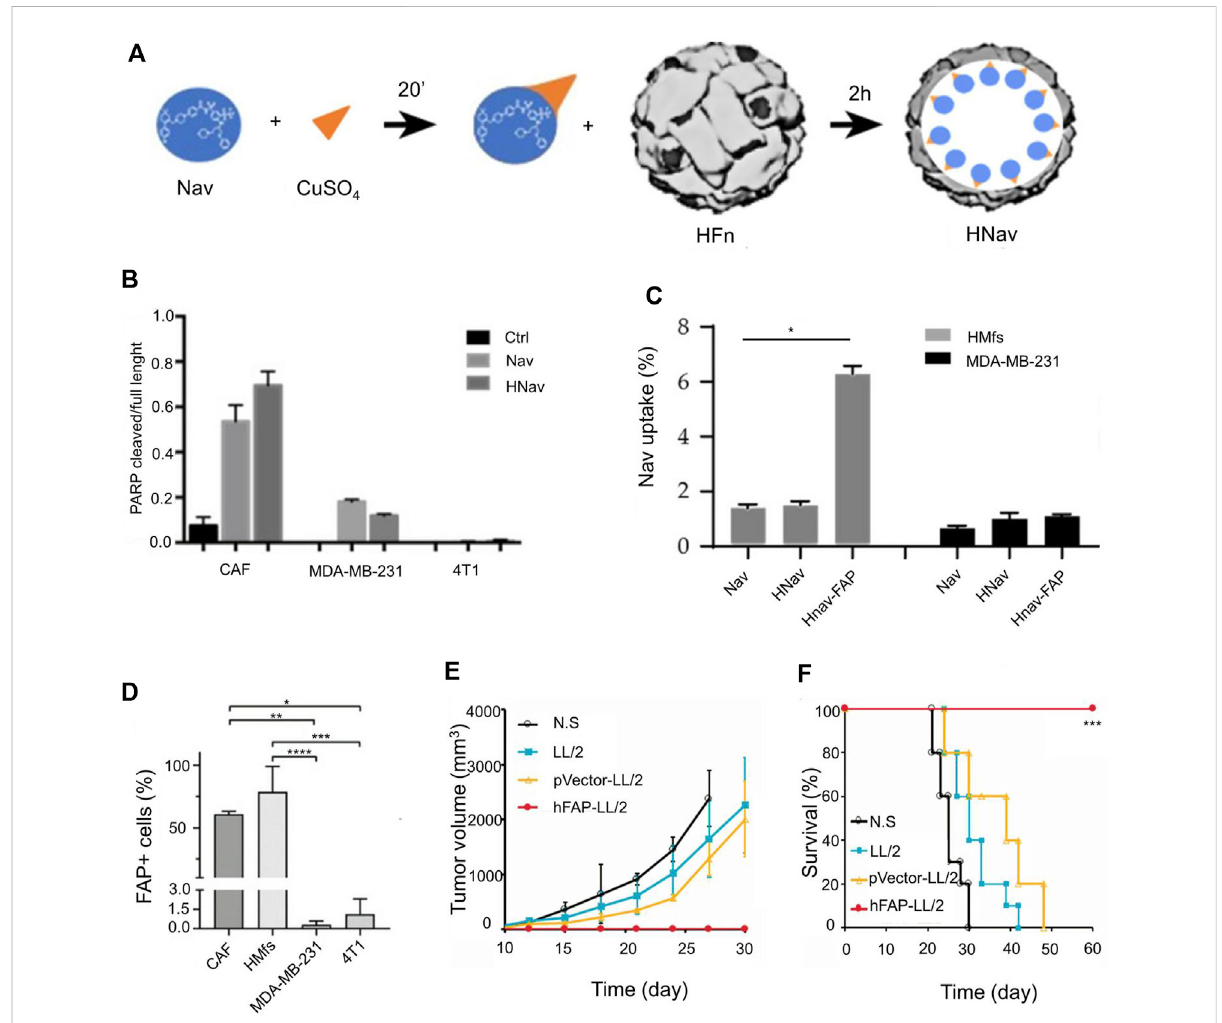
FIGURE 4 Engineered H-ferritin nanocage targets tumor-associated fi broblasts to induce anti-tumor immune response. (A) Development of H-Ferritin nanocages loaded with Navitoclax (Hnav) and HNav- fi broblast activation protein (FAP). (B) Calculated lysis of PARP-1 when CAF cells and breast cancer cells are incubated with 1 µM Nav or HNav. (C) Human activated myo fi broblasts (HMFs) and breast cancer cellular uptake of Nav. (D) FAP expression in CAFs, HMfs, MDA-MB-231, and 4T1 cells. (E) The tumor growth curves in different treatment groups. (F) The survival rate in different treatment groups. Reproduced with permission from (Chen et al., 2019; Sitia et al.,